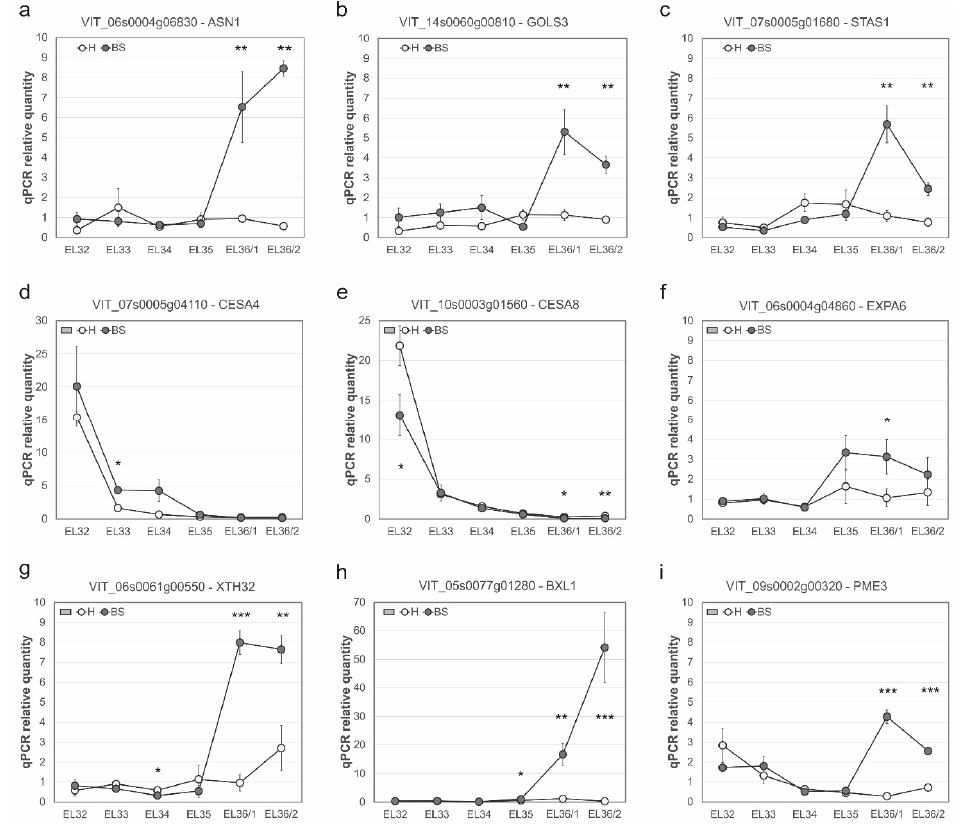
Figure 2. Relative expression of selected genes determined by qPCR related to the primary metabolism and cell wall modifications. NRQs are presented for healthy (H) and berry shrivel (BS) affected grape clusters in the rachis. Samples were collected at six sampling dates throughout the berry development and berry ripening in 2013 (EL-32, EL-33, EL-34, EL-35, EL-36/1, EL-36/2).